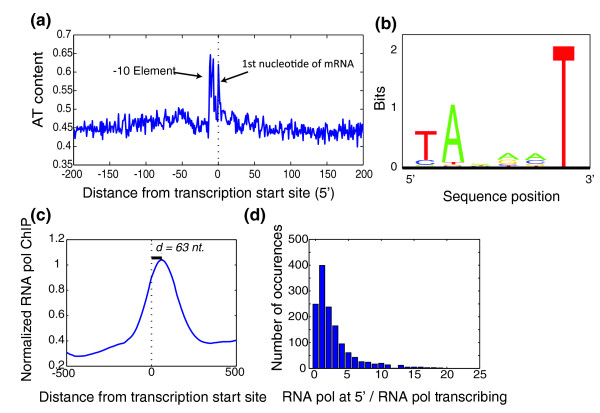
Transcription initiation in S. elongatus. (a) AT content of the transcription start. The AT content from -200 to +200 from the start site of transcription was averaged for all mRNAs. A strong enrichment in AT content is observed at the -10 element as well as a strong preference for adenine at the first nucleotide of a transcript. (b) -10 element consensus logo. A consensus -10 element similar in sequence to that determined for E. coli was identified through sequence alignment (Materials and methods). (c) Normalized RNA pol occupancy at promoter. For each of the top 500 expressed mRNAs, the RNA pol occupancy was normalized to a mean occupancy of 0.5 per nucleotide, and then averaged across mRNAs from -500 to +500. A peak in RNA pol occupancy is observed, on average, 63 nucleotides within the RNA transcript, suggesting potential stalling of RNA pol after initiation of transcription rather than at the promoter. (d) RNA pol retention ratio at the promoter is variable. The relative amount of RNA pol at the 5' end versus RNA pol in the ORF varies from transcript to transcript. RNA pol at the 5' end was calculated as the mean occupancy in a 200-nucleotide window centered at the +63 nucleotide. RNA pol transcribing was calculated as the mean occupancy in a 200-nucleotide window centered in the middle of the first ORF.